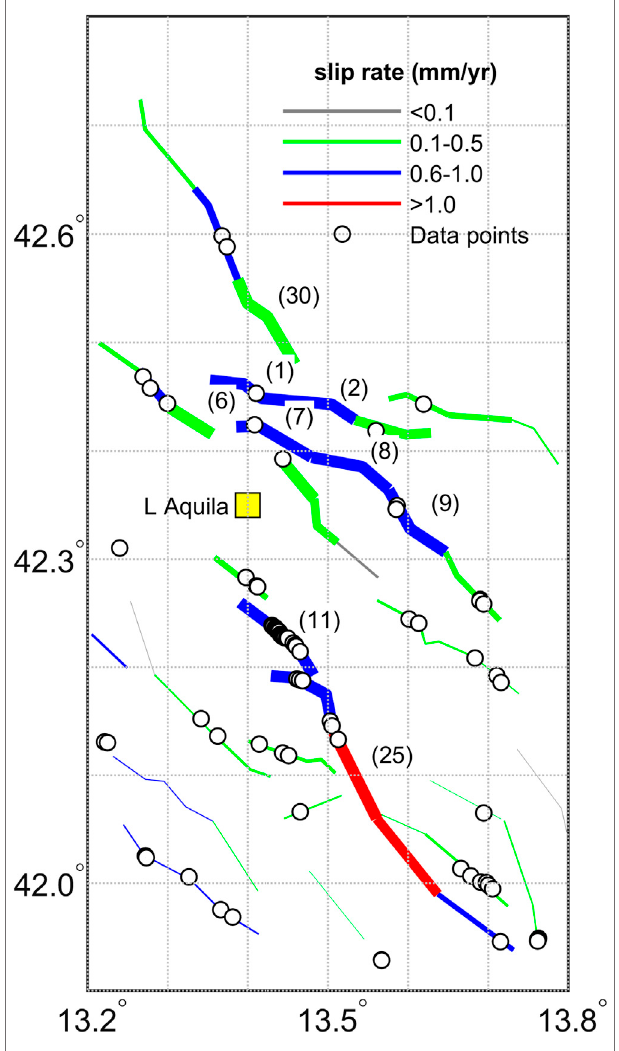
FIGURE 9 | Participation of MF-sections to typological seismic risk in L ’ Aquila (Yellow Square) for collapse condition of an L type – building constructed before 1919. Slip rate measurement points available in the Fault2sha CAD (empty black circles) are superposed on the MF-section traces(colorcodedaccordingtotheirslipratecategory).OnlytheMF-sections that participate the most (the upper 10% of the distribution) are identi fi ed (corresponding MF-section name is provided in Table 3 ).